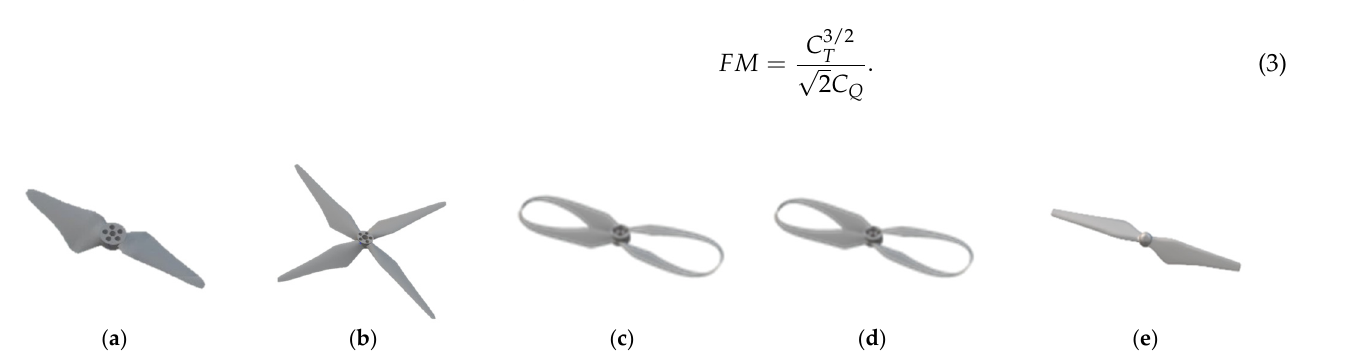
Figure 2. Five propellers: ( a ) two-blade propeller (#1), ( b ) four-blade propeller (#2), ( c ) loop-type propeller (#3), ( d ) wide chord loop-type propeller (#4), and ( e ) DJI Phantom propeller (#5).